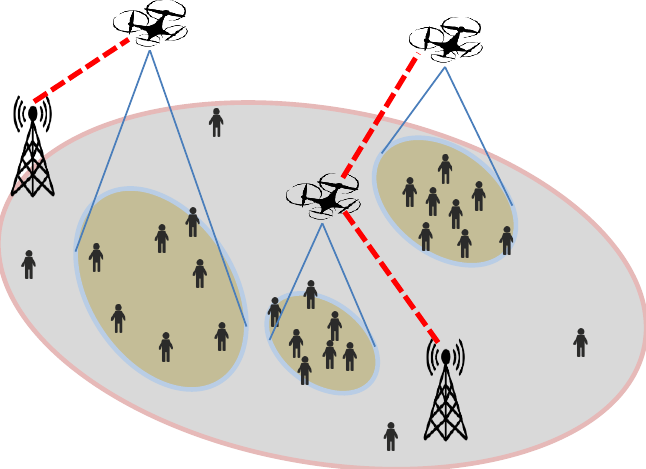
Figure 9. Example of UAV-BSs’ application